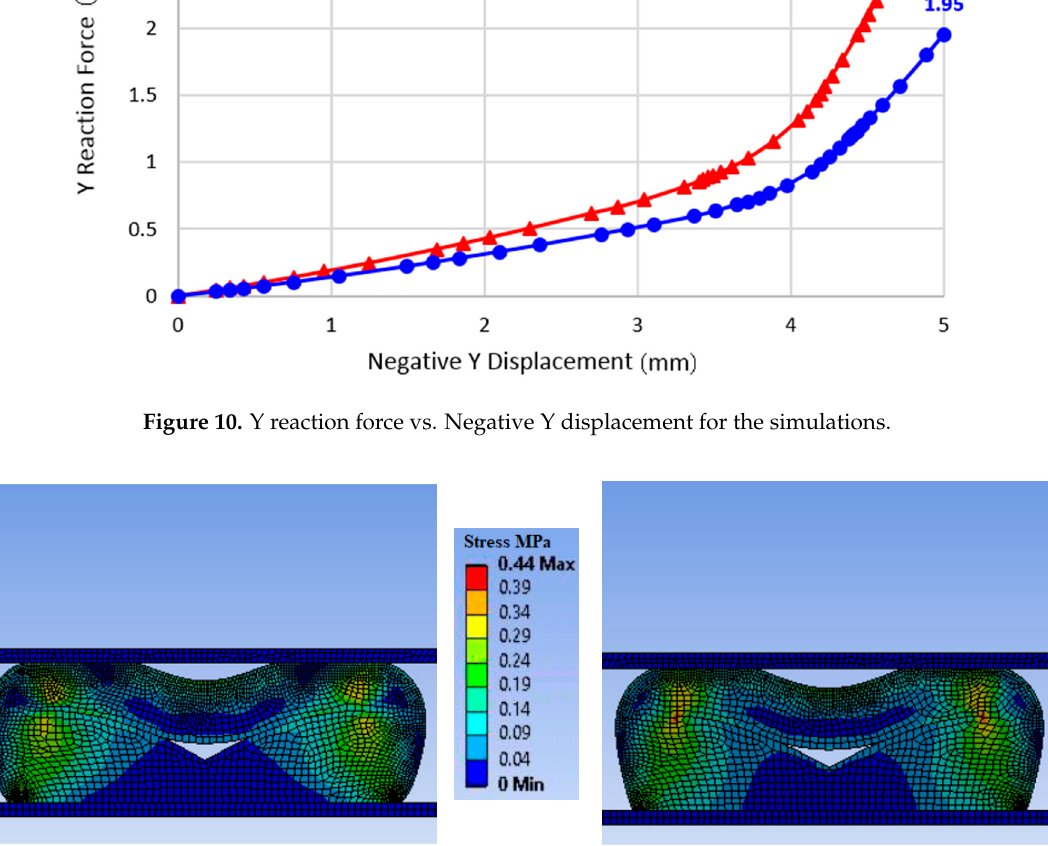
Figure 12. Effect of surface friction on vertical reaction force for multiple displacements.